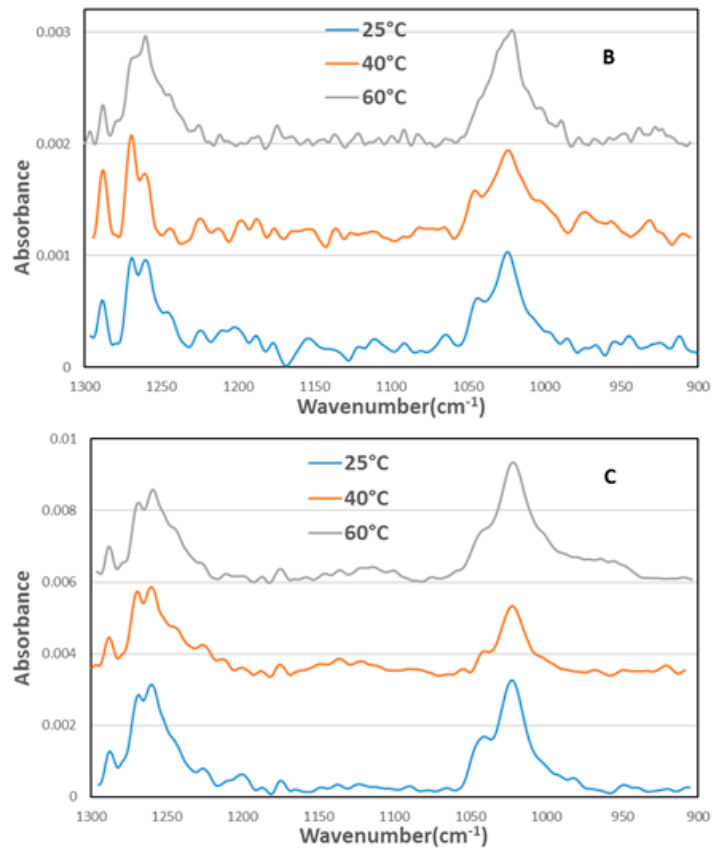
Figure 4. FTIR spectra of chalcopyrite surface after treated at different temperatures for 2 h with ( A ) PAX 5 × 10 − 5 M; (B) PAX 1 × 10 − 4 M; ( C ) 5 × 10 − 4 M.